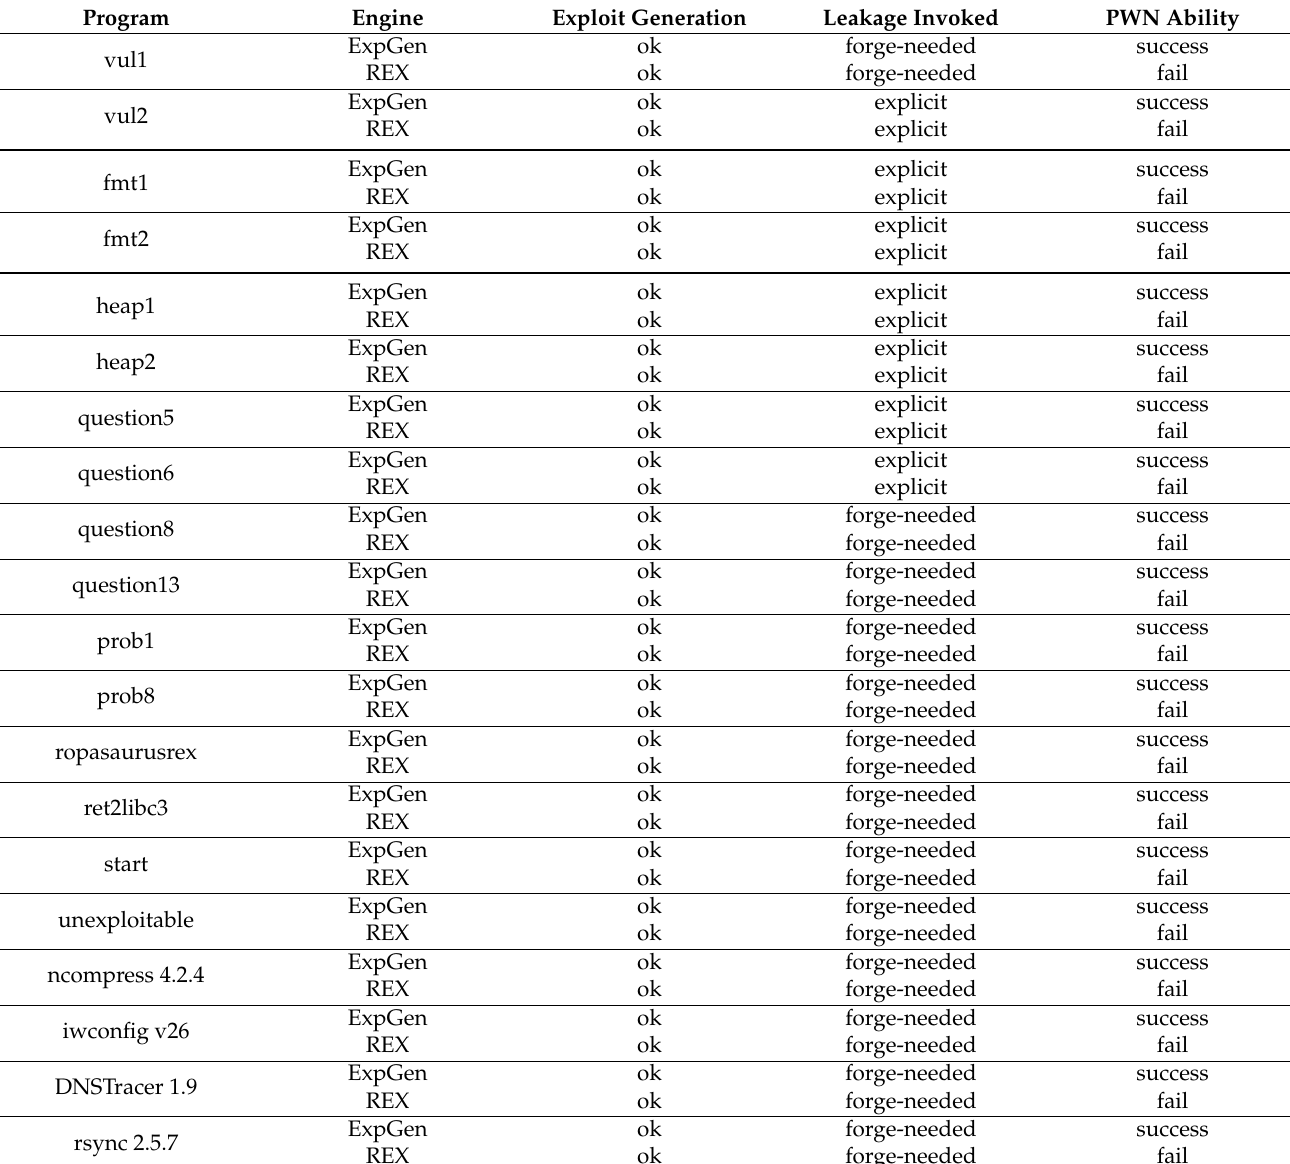
Table 4. Experimental results of exploit